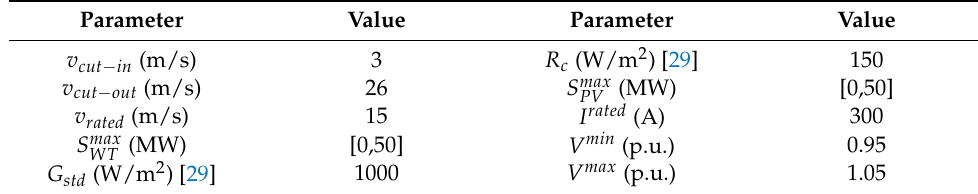
Table 3. System input parameters.